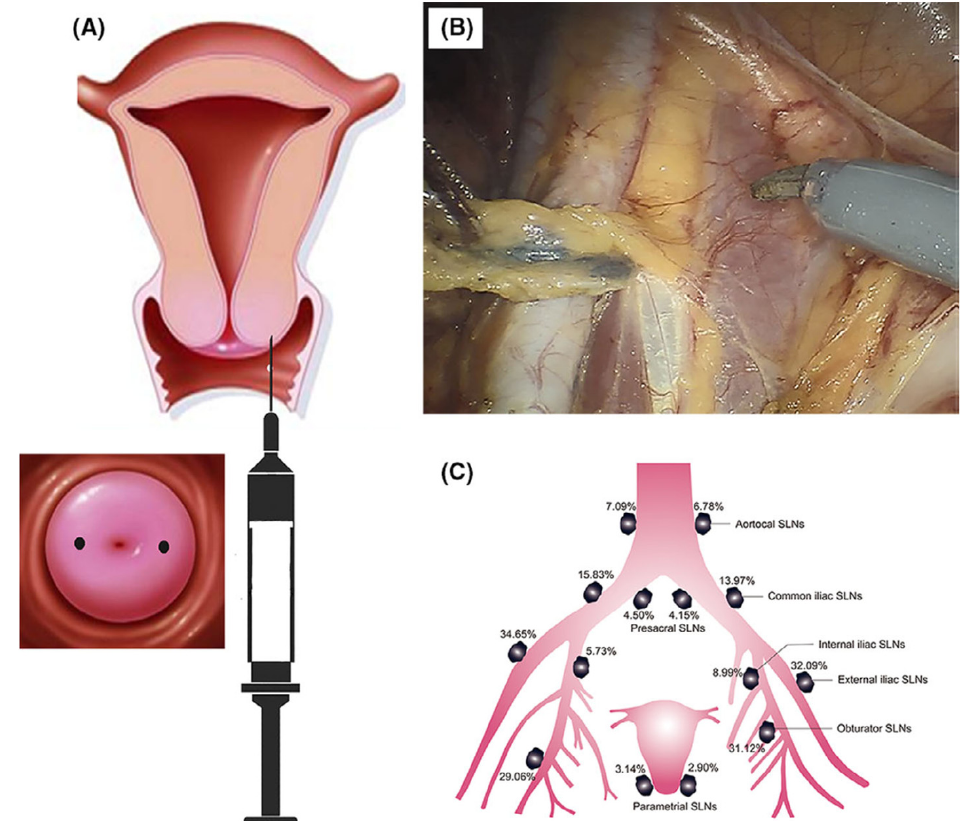
Figure 4. The technique of CNSI application in SLNB for assessing lymphatic spread of early-stage cervical cancer [81]. ( A ) Injecting CNSI into the ectocervix at the 3 and 9 o’clock positions superficially by a skin test needle, approximately 5–10 mm from the tumor border and perpendicular to the cervix surface. ( B ) The black-stained SLNB was identified adjacent to the external iliac artery and vein, which belonged to SLNB of external iliac region. ( C ) Locations of SLNBs on each side of the pelvis. Copyright 2020, Wiley.